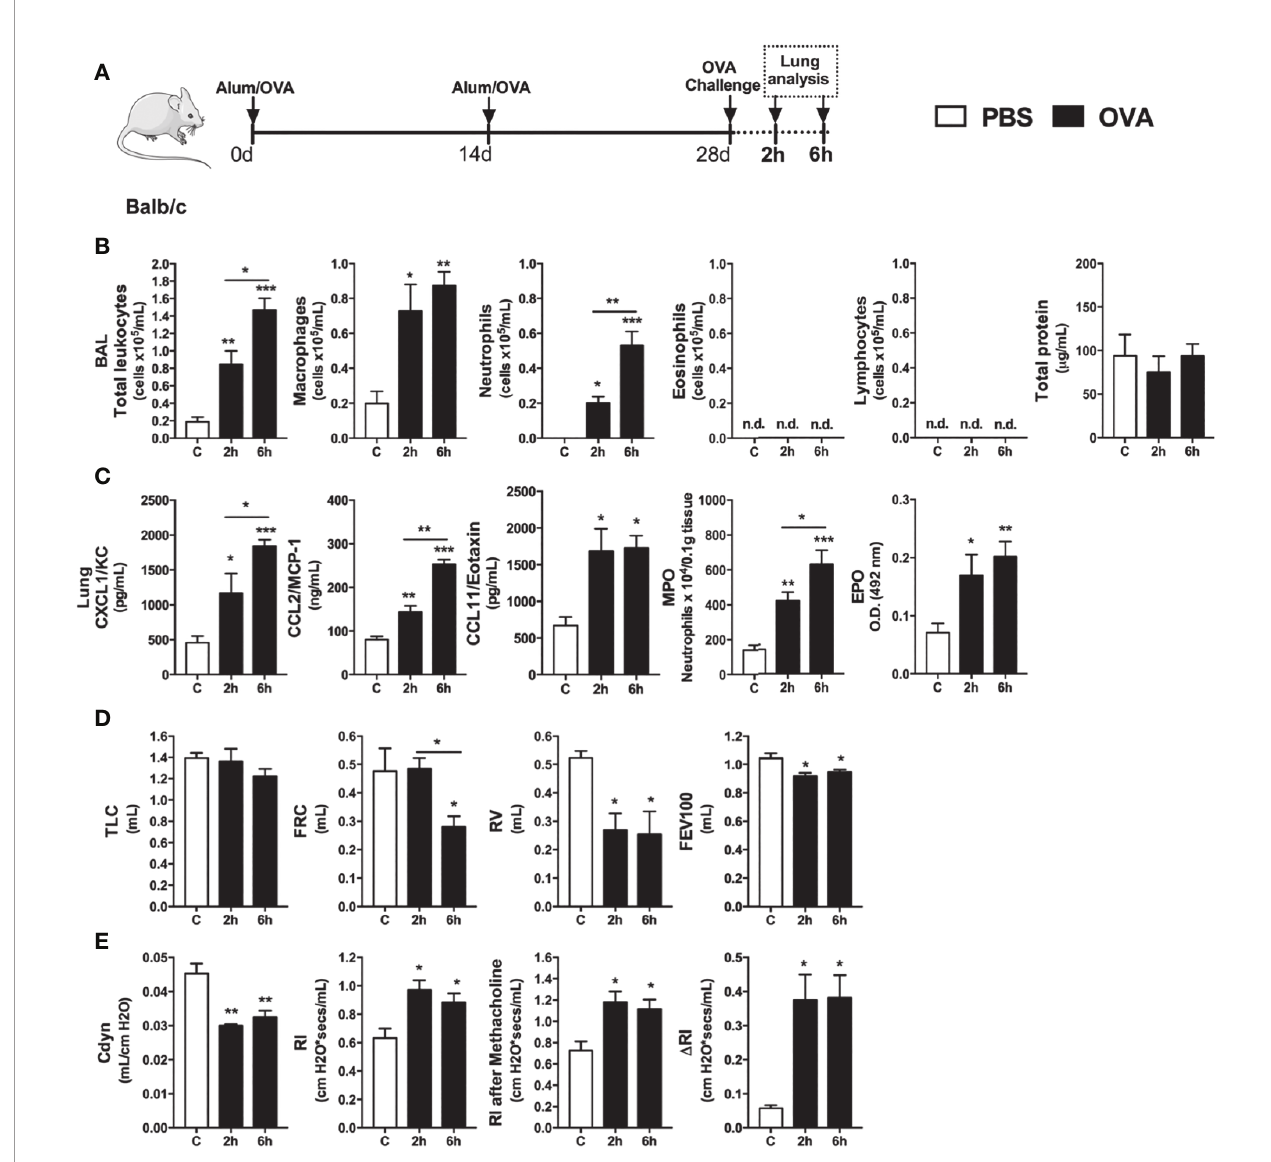
FIGURE 1 | Characterization of early in fl ammatory in fi ltrate and pulmonary mechanics. In fl ammatory parameters were evaluated 2 and 6 h after a single challenge with OVA. (A) Schematic representation of the experimental design. (B) Assessment of leukocytes in fl ux and blood leakage into airways. (C) Chemokine levels, MPO and EPO activity assay in lung tissue. Assessment of pulmonary mechanics for (D) lung volumes, (E) compliance and lung resistance. n = 8 for each group, * for P < 0.05 ** for P < 0.01 *** for P < 0.001. TLC, total lung capacity; RV, residual volume; FRC, functional residual capacity; FEV100, forced expiratory volume in 100 ms; Cdyn, dynamic compliance; Rl, lung resistance; D Rl, methacholine-evoked